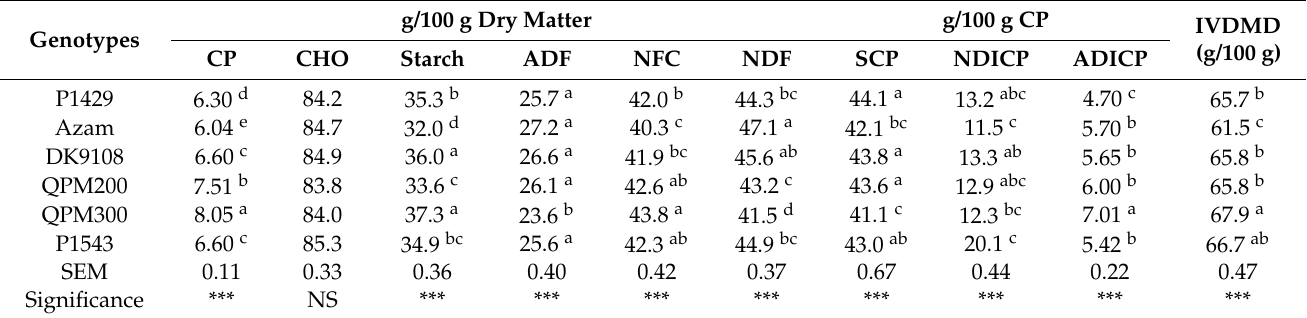
Table 3. Chemical composition (g/kg DM) and in vitro dry matter digestibility (DMD) of maize after ensiling for 90